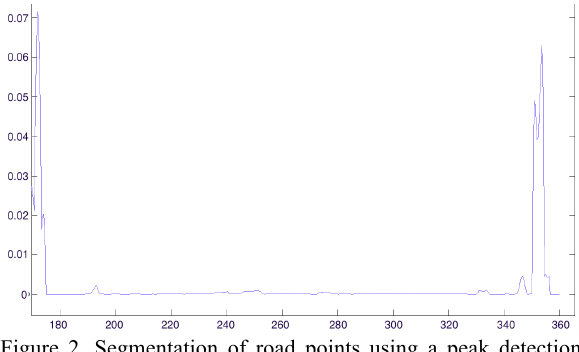
Figure 2. Segmentation of road points using a peak detection based on the second eigenvalue during PCA analysis of a cross section of the road.